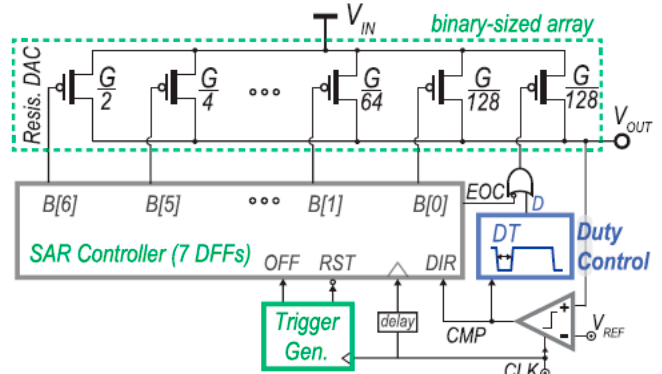
Figure 25. The architecture of PD Compensation and Sub-LSB Duty Control DLDO [53].